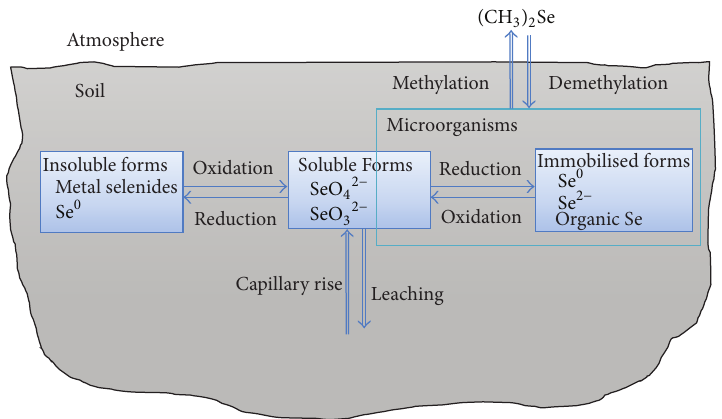
Figure 5: Cycle of Se in soil. Double arrows show preferred pattern for biodegradation (extracted from